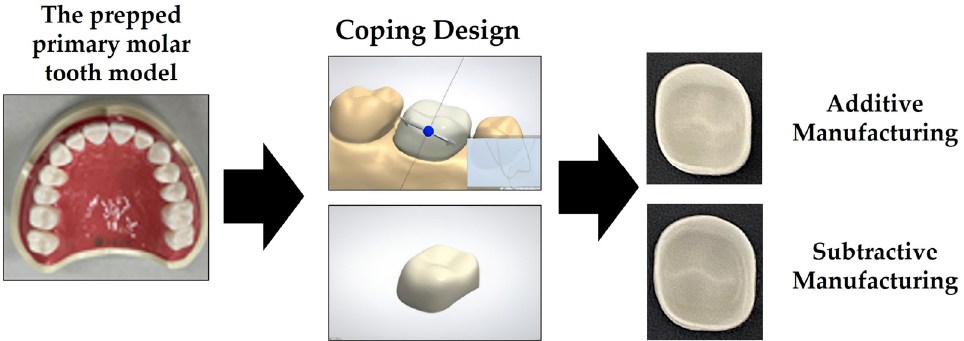
Figure 1. Schematic of the design and preparation of the zirconia specimens used in this study.